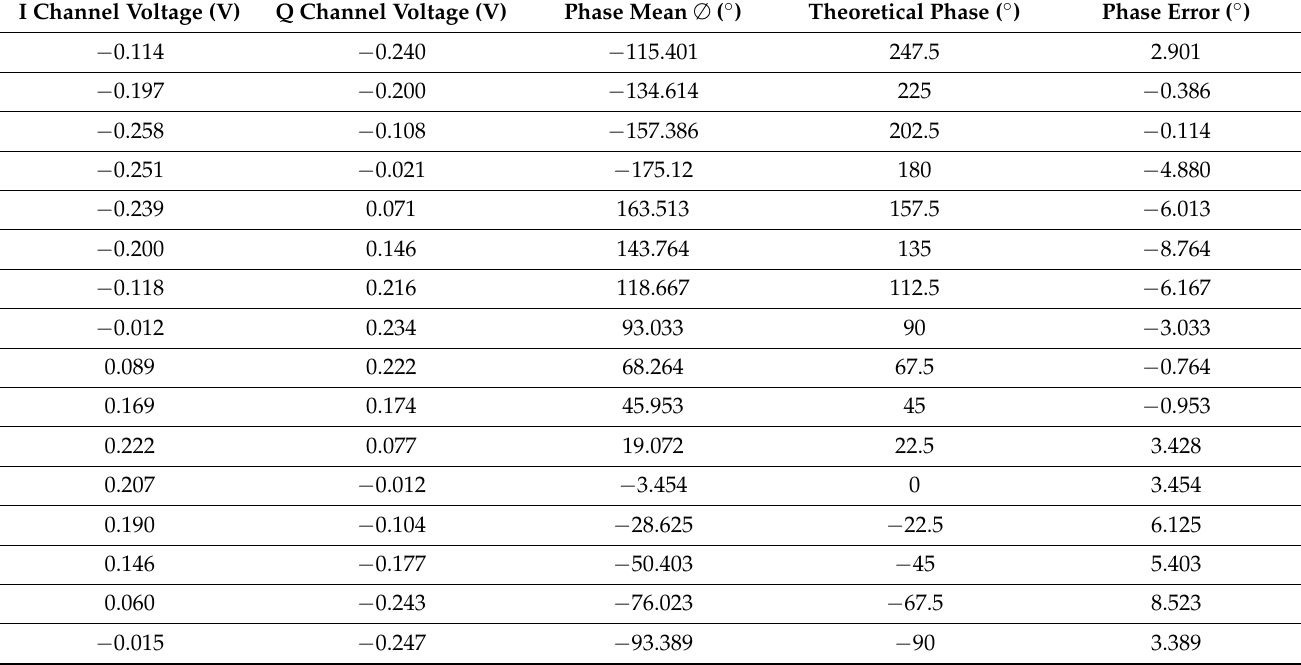
Table 3. Data after error